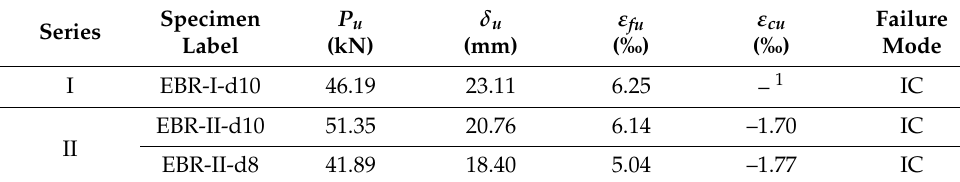
Table 3. Experimental results.